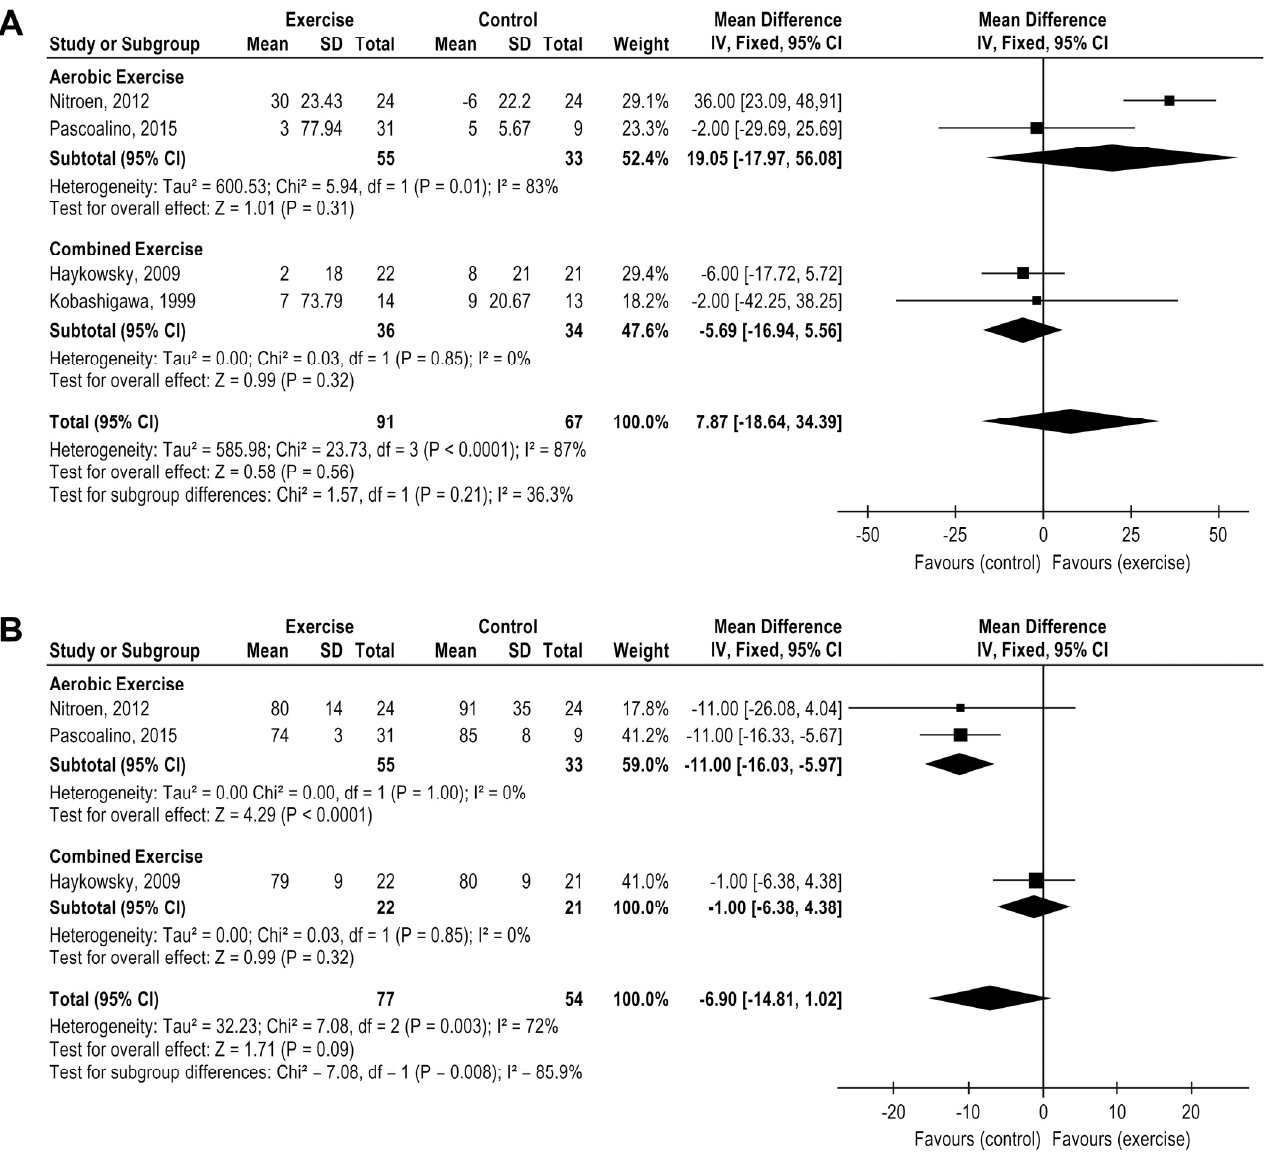
Figure 4. Impact of exercise training on blood pressure (mmHg) in HTx ( A ) exercise versus control group for systolic blood pressure ( B ) exercise versus control group for diastolic blood pressure.